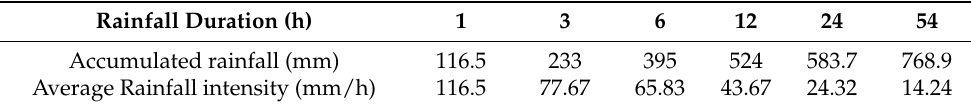
Table 3. Rainstorm condition in the Laomao Mountain area on 27 July